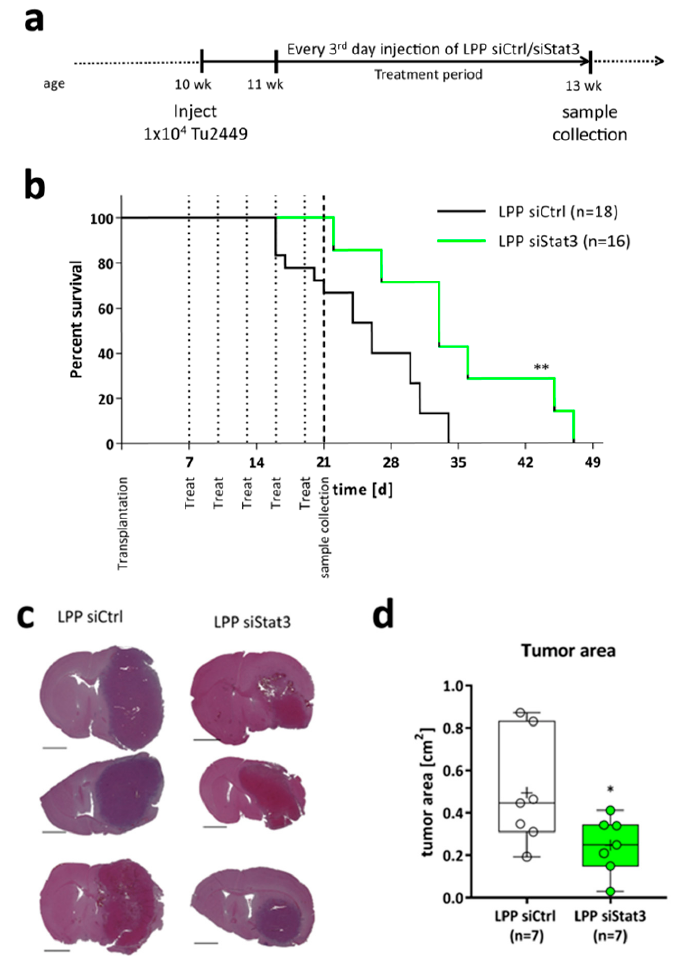
Figure 4. ( a ) Schematic presentation of the in vivo experiments. Briefly, 42 mice were injected with 10,000 Tu2449 cells into the right striatum. After 7 days the mice were randomly divided into two groups of 21 animals each and intracranial treatment was performed every third day. After 21 days 10 mice were euthanized for histological and molecular analysis. The remaining mice were monitored for long-term survival. Mice without established tumors were excluded from the analysis (3 (1 for histology; 2 for survival) for LPP siCtrl; 5 (1 for histology; 4 for survival) for LPP siStat3) ( b ) Kaplan-Meier-Survival Plot of B6C3F1 mice after implantation of Tu2449 and treatment with LPP siCtrl or LPP siStat3. The vertical dotted lines depict the treatment days, the vertical dashed line the day of sample collection. LPP siStat3 treatment significantly increases median survival from 26 days to 33 after LPP siCtrl and LPP siStat3 treatment respectively ( c ) Three representative brain sections with tumors 21 days after tumor cell implantation and treatment with LPP siCtrl (left side) or LPP siStat3 (right side); scale bar: 2 mm. ( d ) Box-Plots (min-to-max) with all samples displayed as circles; the horizontal line in the box depicts the median value, the plus-symbol the mean of tumor areas 21 days after tumor cell implantation after treatment with LPP siCtrl or LPP siStat3. *: p < 0.05; **: p < 0.01 compared to LPP siCtrl.